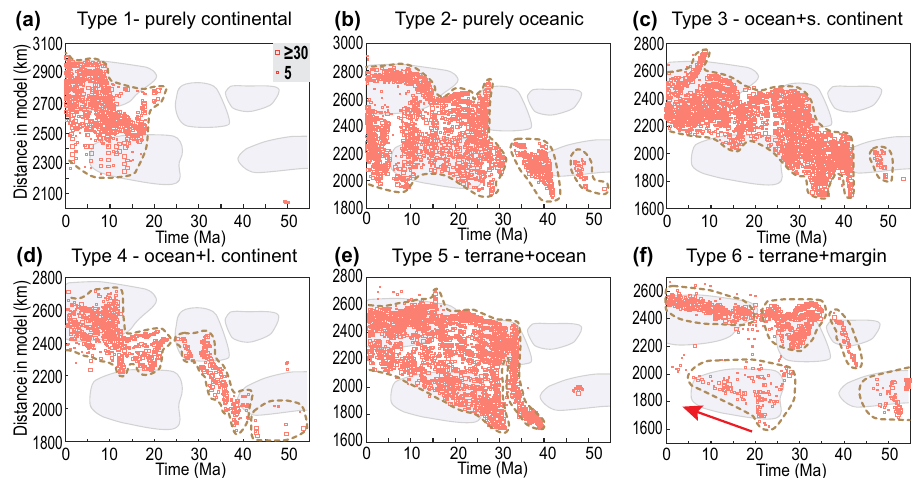
Fig.7|Magmatichistoryindifferentnumericalmodels.a – f Magmatichistoryin Type 1 (Run 3, Figures S5c, S6c), Type 2 (Run 6, Figures S7b, S8b), Type 3 (Run 9, FiguresS9c,S10c),Type4(Run13,FiguresS11c,S12c),Type5(Run18,FiguresS13d, S14d), and Type 6 (Run 23, Fig. 4) models, respectively. Background shadings